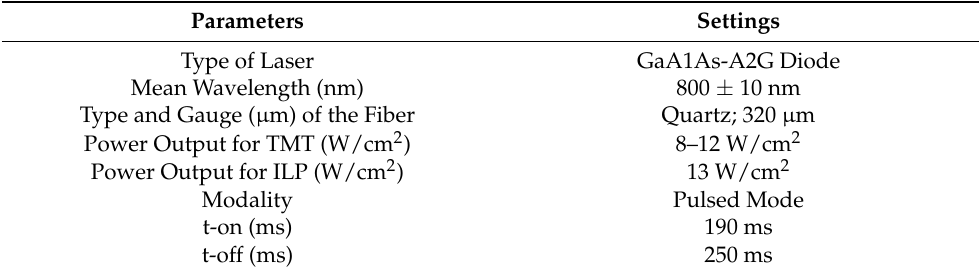
Table 1. Laser Parameters. Parameters Settings Type of Laser GaA1As-A2G